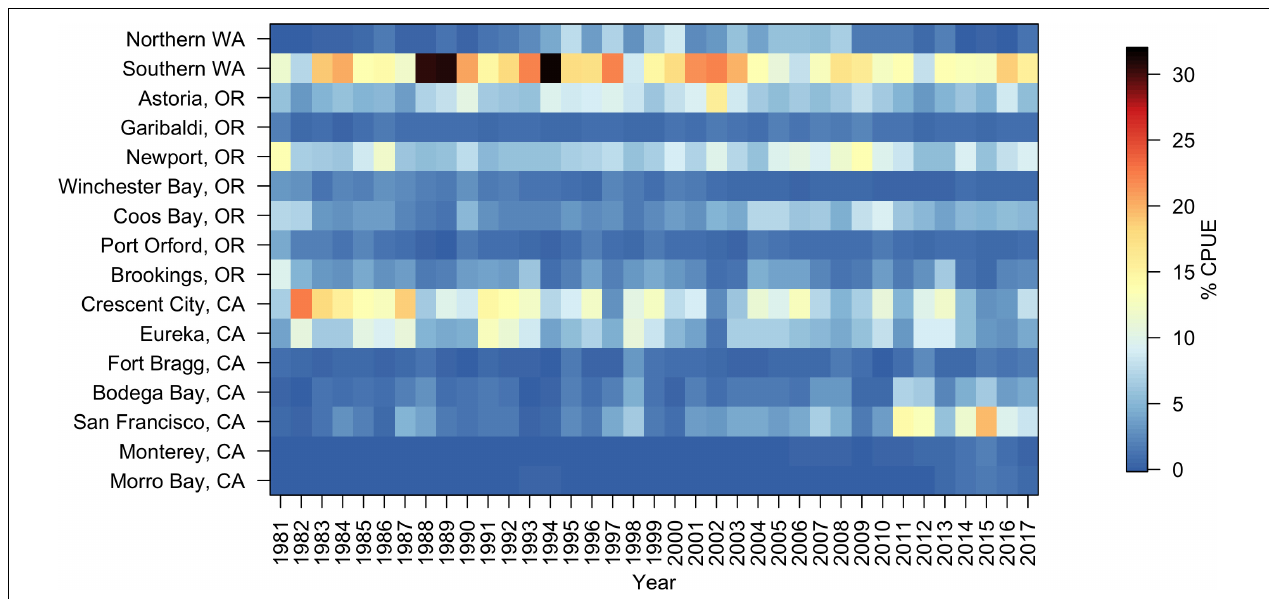
FIGURE 4 | Percent of total Dungeness crab commercial catch per unit effort (CPUE) landed annually in 16 U.S. west coast ports from 1981 to 2017. Warm colors indicate a high percentage of the total annual CPUE and cool colors indicate a low percentage of the total annual CPUE. Total annual CPUE was calculated as kilograms caught per number of fish tickets per year. Ports correspond to those shown in Figure 1 and latitudes are listed in Table 4 .